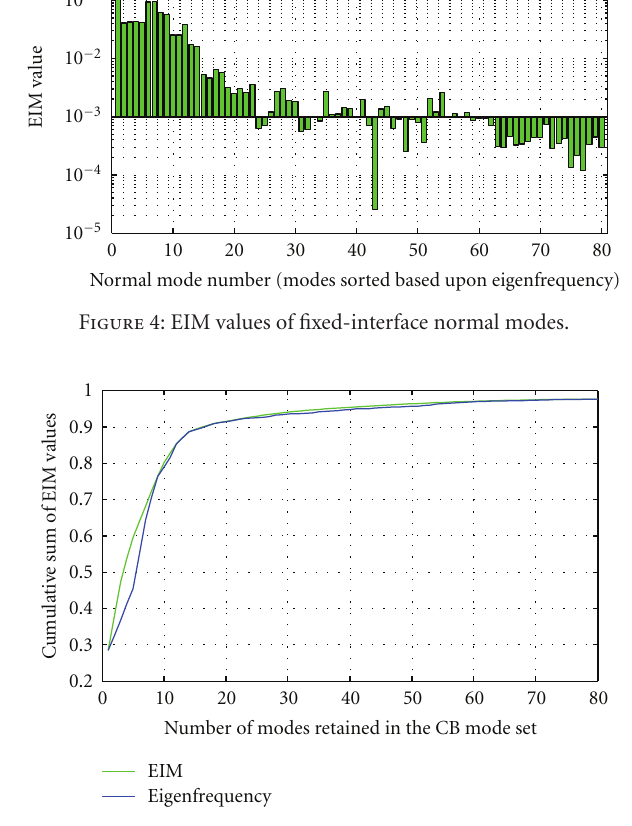
Figure 5: Cumulative EIM sum according to the modal ordering schemes based upon EIM value and eigenfrequency,